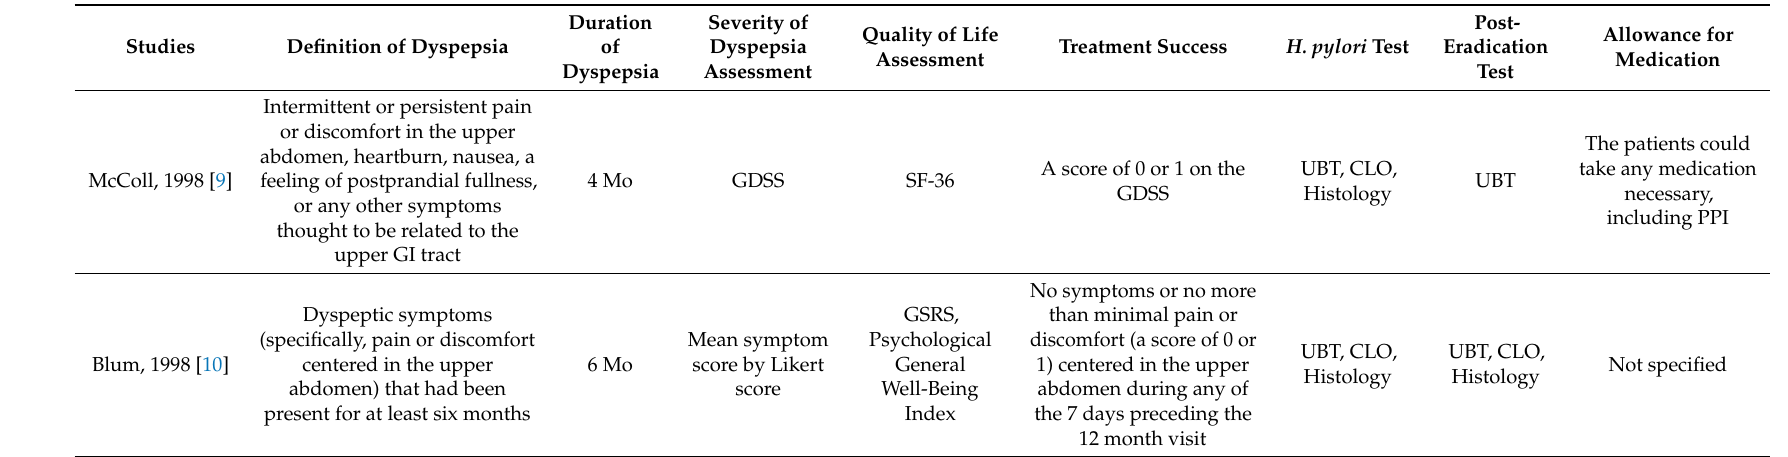
Table 2. Definition of dyspepsia and symptom